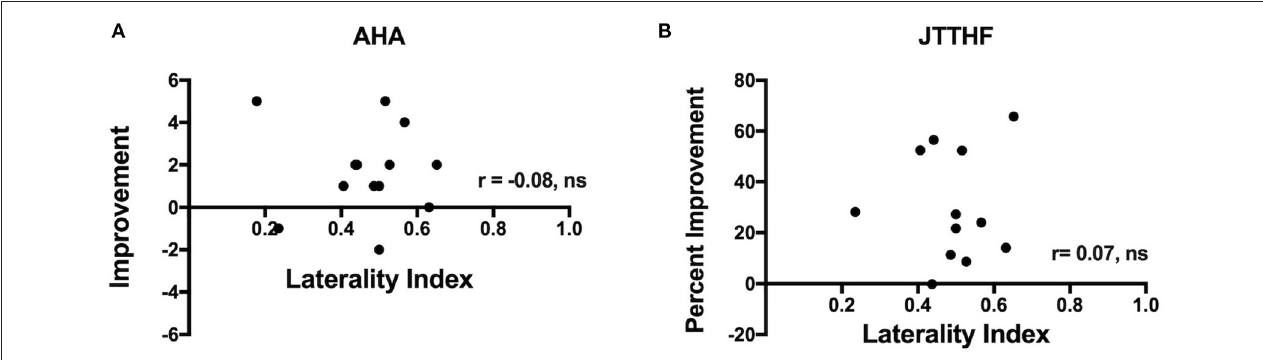
FIGURE 4 | Plots showing correlations between laterality index and improvement in (A) AHA and (B) JTTHF immediately after the intervention. Note that one JTTHF change value was > 3.5 SD from the mean and was excluded from the correlation.